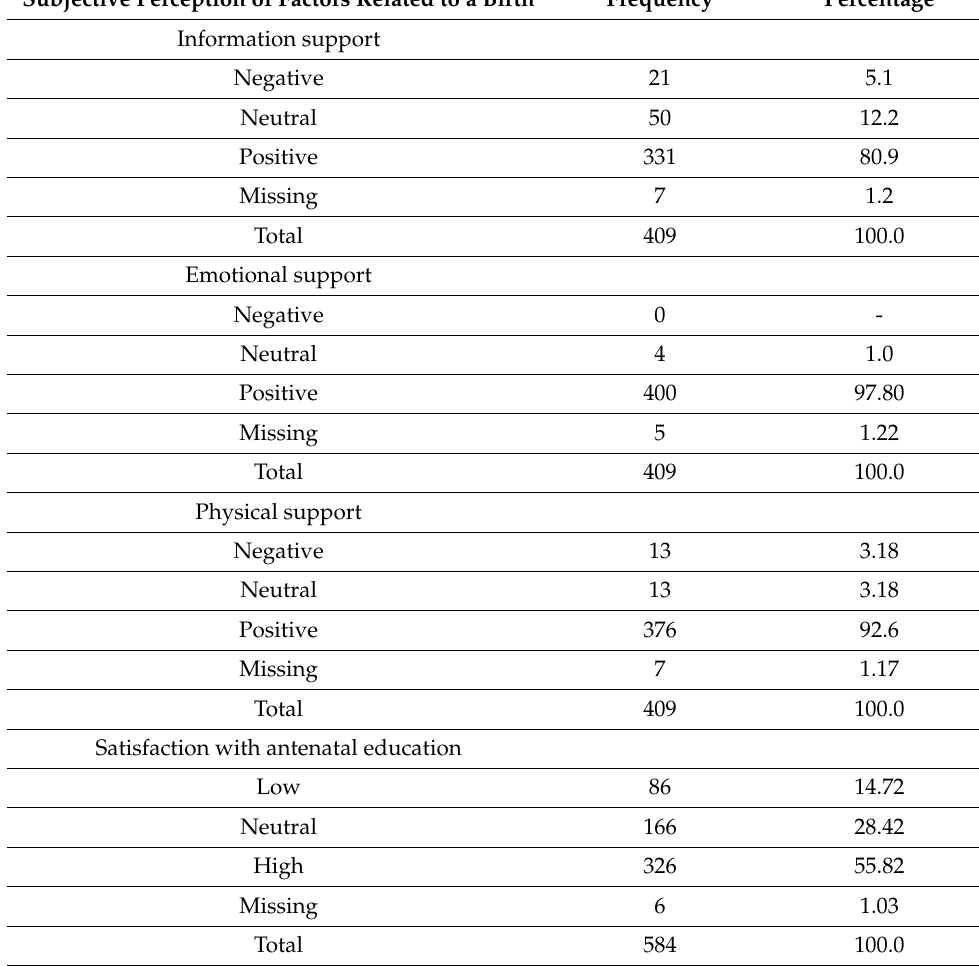
Table 2. Subjective perception of a support during birth and antenatal education, attitudes toward pregnancy, and levels of postpartum depression among the study